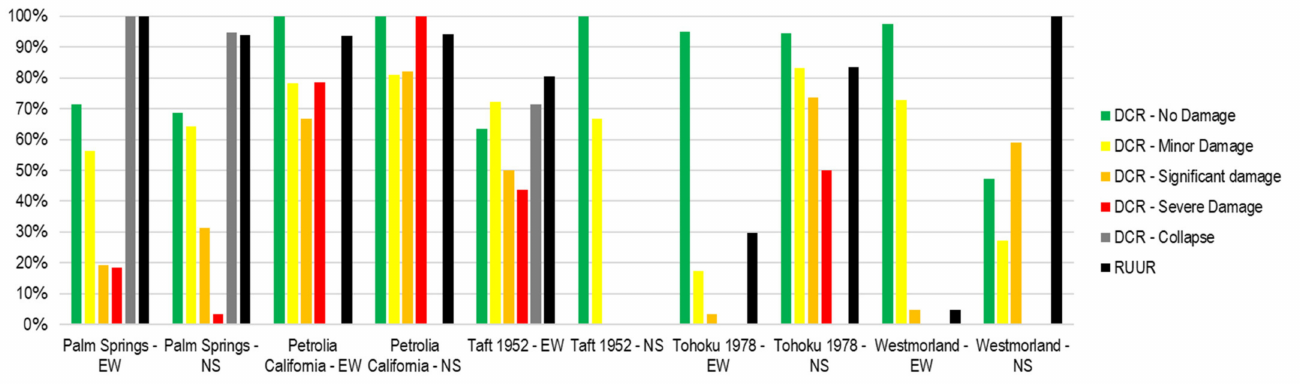
Figure 23. DCR and RUUR for ductility ratio of the validation